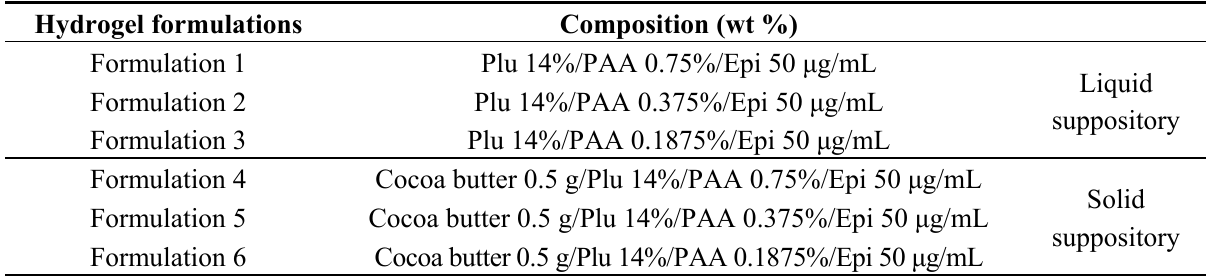
Table 1. Epirubicin (Epi) in Pluronic (Plu)/polyacrylic acid (PAA) hydrogels of both liquid and solid suppository